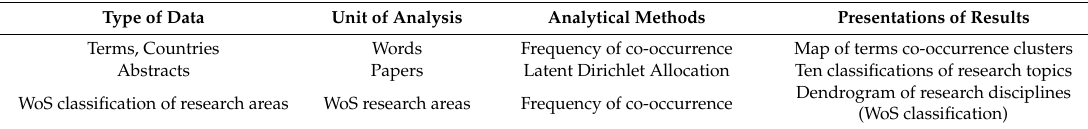
Table 1. Summary of analytical techniques for each data